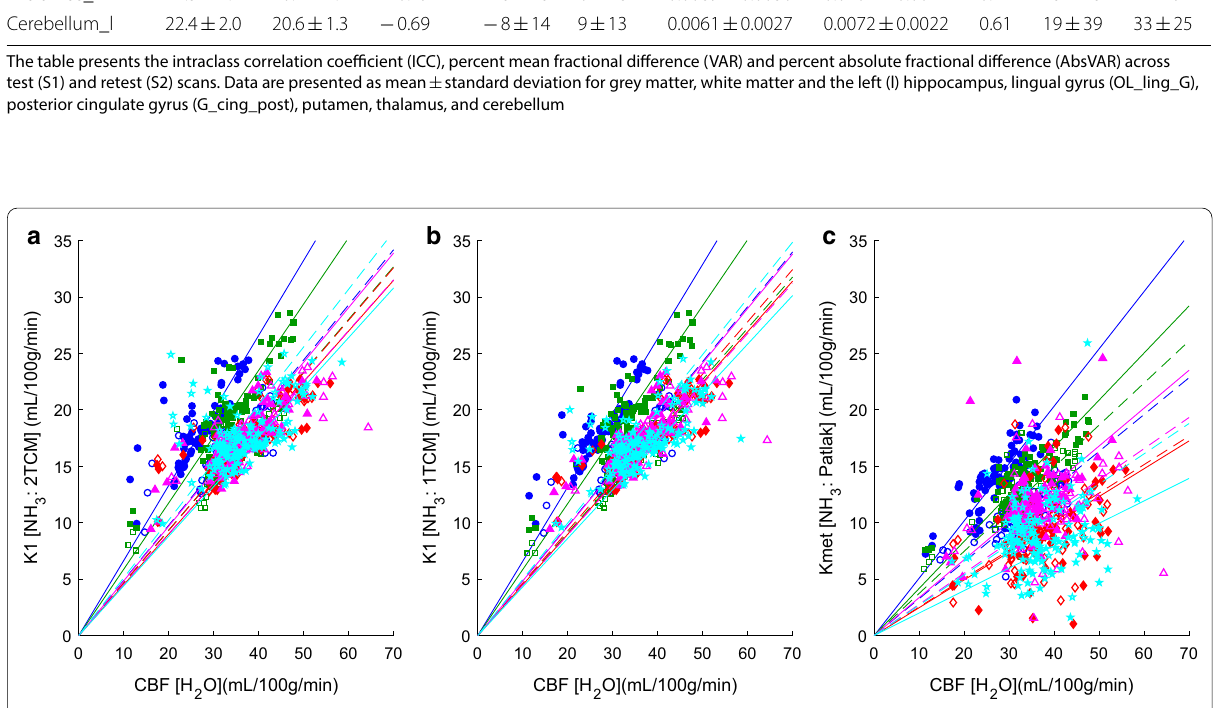
The table presents the intraclass correlation coefficient (ICC), percent mean fractional difference (VAR) and percent absolute fractional difference (AbsVAR) across test (S1) and retest (S2) scans. Data are presented as mean